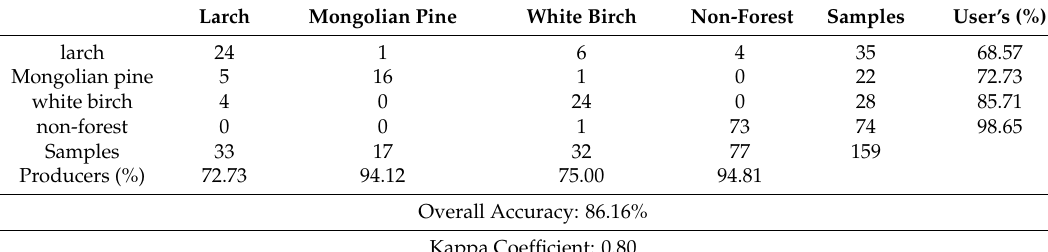
Table 2. Confusion matrix of forest classification.